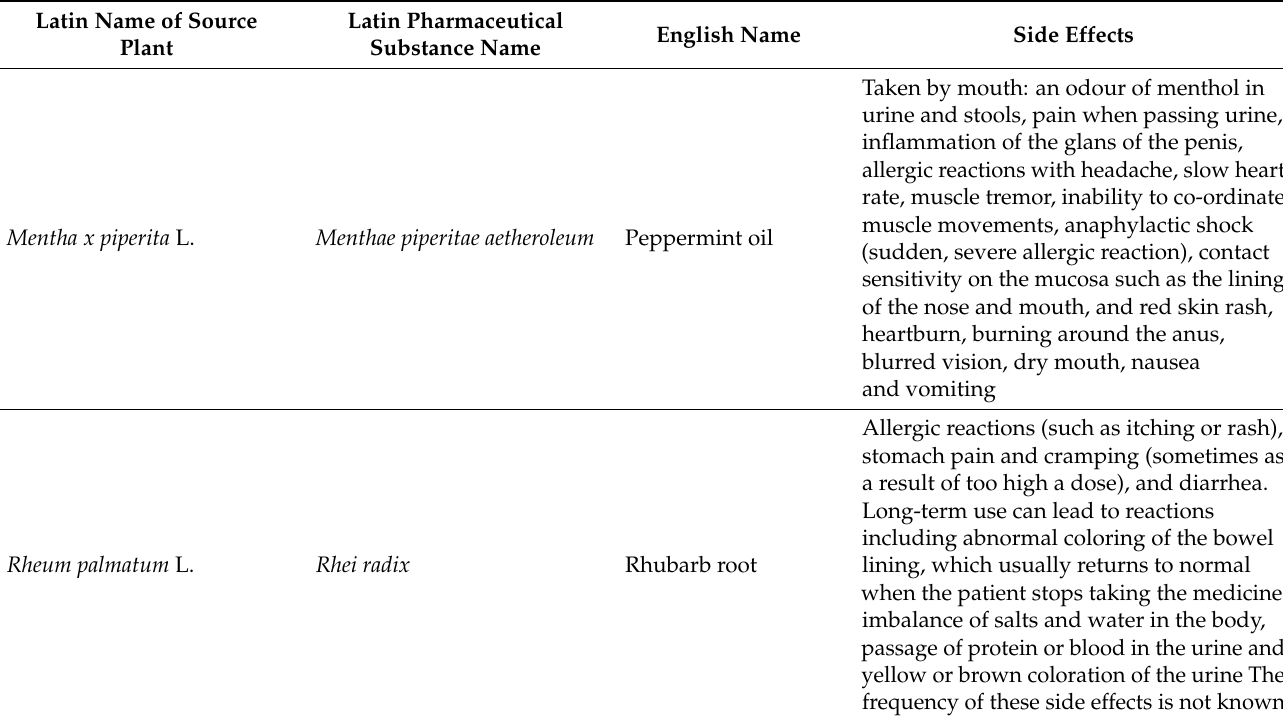
Table 3. Plant products disturbing kidney function and electrolyte balance listed in EMA